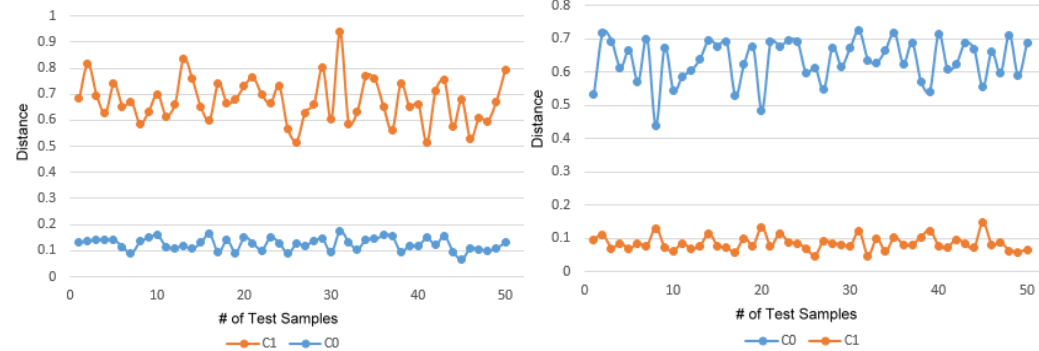
Figure 13. Visualized test result for the distance of the C 0 and C 1 classes when the tested 4% preload data were near C 0 ( left figure), and the tested 2% preload data were near C 1 ( right figure). Table 1. The confusion matrix.